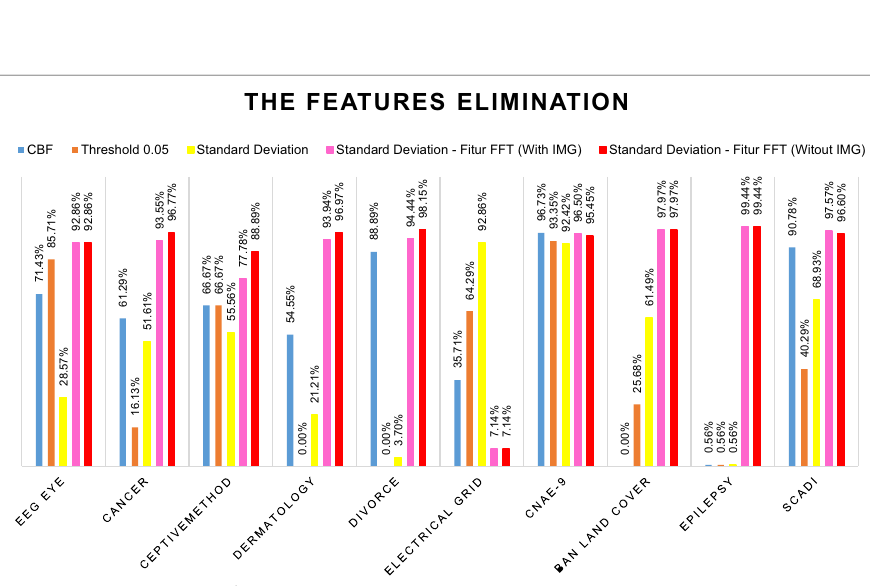
Fig.6 Comparison Feature